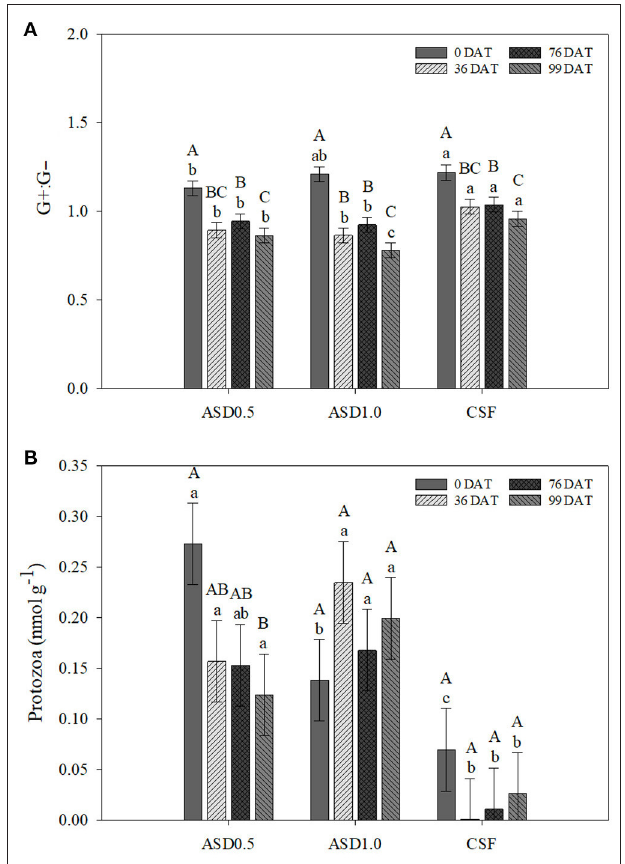
FIGURE 2 | Ratio of G + :G − (A) and PLFA concentrations of protozoa (B) in the bulk soil. As affected by two-way interaction of soil treatment and sampling date across soil depths. Error bars represent standard error. Within a soil treatment, bars sharing the same uppercase letter are not significantly different at P ≤ 0.05 according to Tukey’s HSD. Within a sampling date, bars sharing the same lowercase letter are not significantly different at P ≤ 0.05 according to Tukey’s HSD test. CSF, chemical soil fumigation control with Pic-Clor 60 at a rate of 224kg ha − 1 ; ASD0.5, anaerobic soil disinfestation with 6.9 m 3 ha − 1 of molasses and 11Mg ha − 1 of composted poultry litter; ASD1.0, anaerobic soil disinfestation with 13.9 m 3 ha − 1 of molasses and 22Mg ha − 1 of composted poultry litter. G + :G − , ratio of Gram positive bacteria to Gram negative bacteria; DAT, days after transplanting.